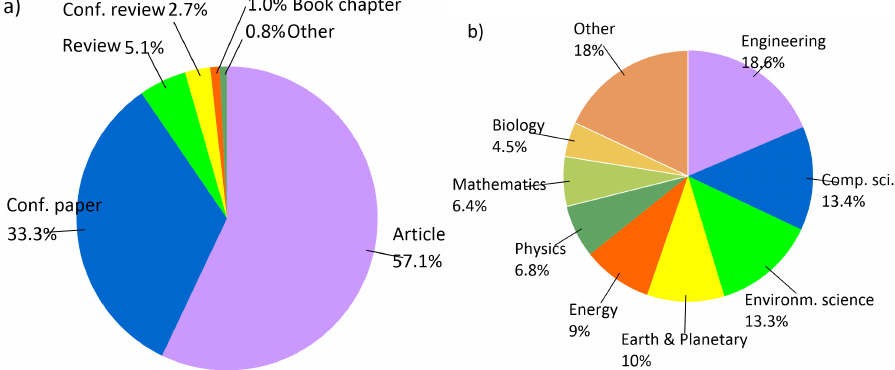
Figure 3. Document classifications: ( a ) types, ( b ) subject areas (Scopus,